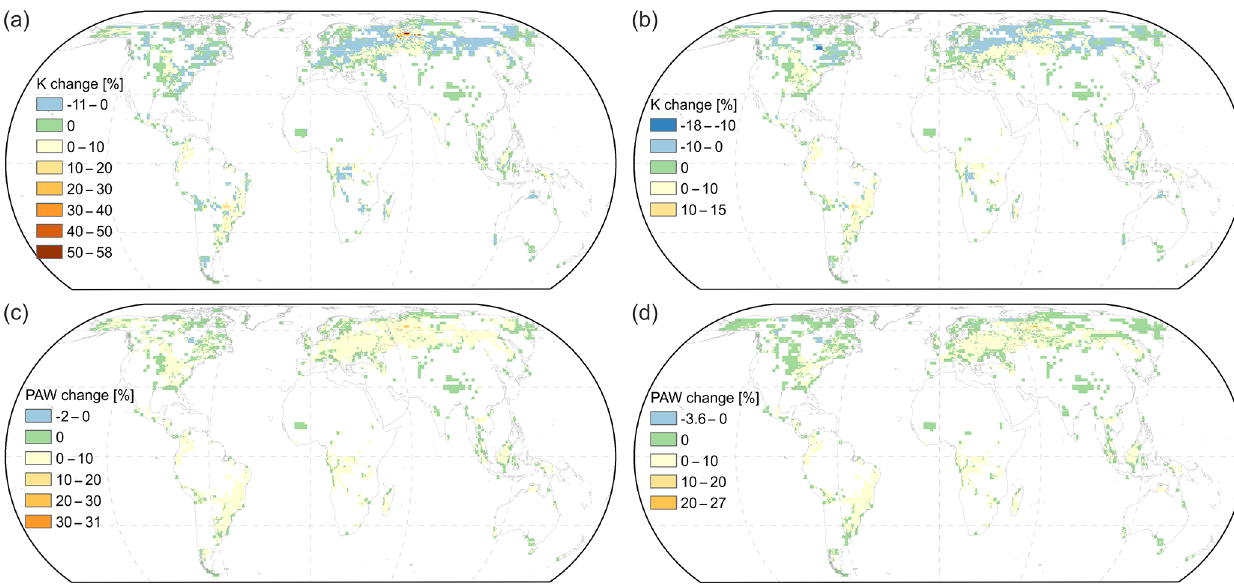
Figure 12. Impacts on soil hydrology estimated according to the equations of Saxton and Rawls (2006) for basalt deployment mass coincident with areas with potential P gaps for the nutrient budget of the N-unlimited AR scenario assuming P concentrations within foliar and wood material corresponding to mean values (Fig. S7a). (a) Hydraulic conductivity (K) changes relative to initial soil values for a fine basalt texture (15.6% clay, 83.8% silt, and 0.6% sand) being deployed. (b) Hydraulic conductivity (K) changes relative to initial soil values for a coarse basalt texture (15.6% clay, 53.8% silt, and 30.6% fine sand) being deployed. (c) Plant-available water (PAW) changes relative to initial soil values for a fine basalt texture (15.6% clay, 83.8% silt, and 0.6% sand) being deployed. (d) Plant-available water (PAW) changes relative to initial soil values for a coarse basalt texture (15.6% clay, 53.8% silt, and 30.6% fine sand) being deployed. ©